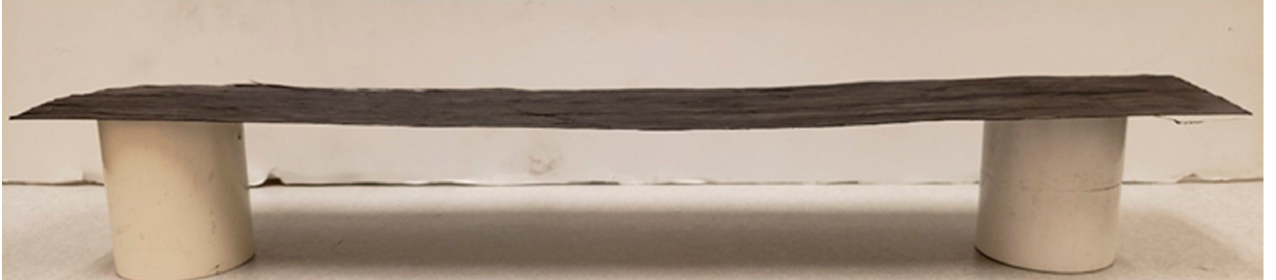
Figure 14. CFRP-CNT sheet (end supported, with thin polymer binder).